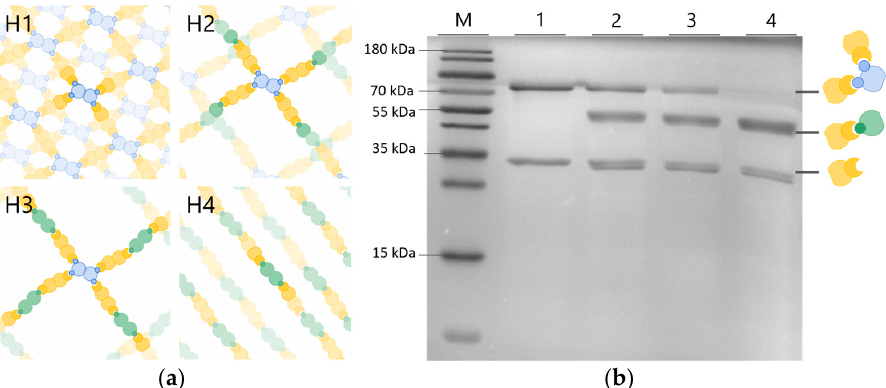
Figure 3. ( a ) Different types of PAD ‐ Hydrogels (H1–H4) with different degrees of crosslinking can be Figure 3. ( a ) Di ff erent types of PAD-Hydrogels (H1–H4) with di ff erent degrees of crosslinking can